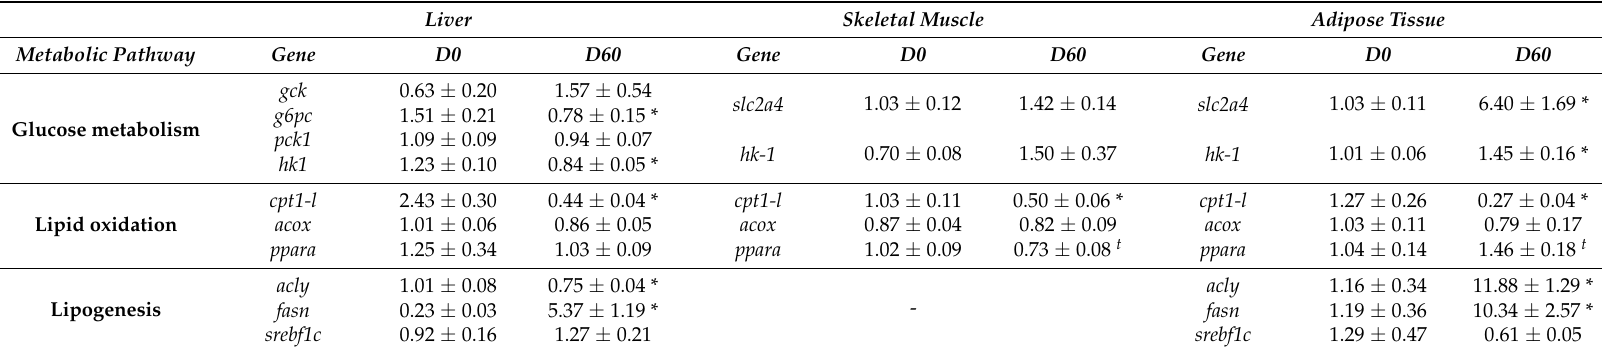
Table 2. mRNA levels of proteins involved in glucose and lipid metabolism in the liver, adipose tissue and skeletal muscle samples from Yucatan minipigs fed on a high fat–high sucrose diet (HFHS) over 2